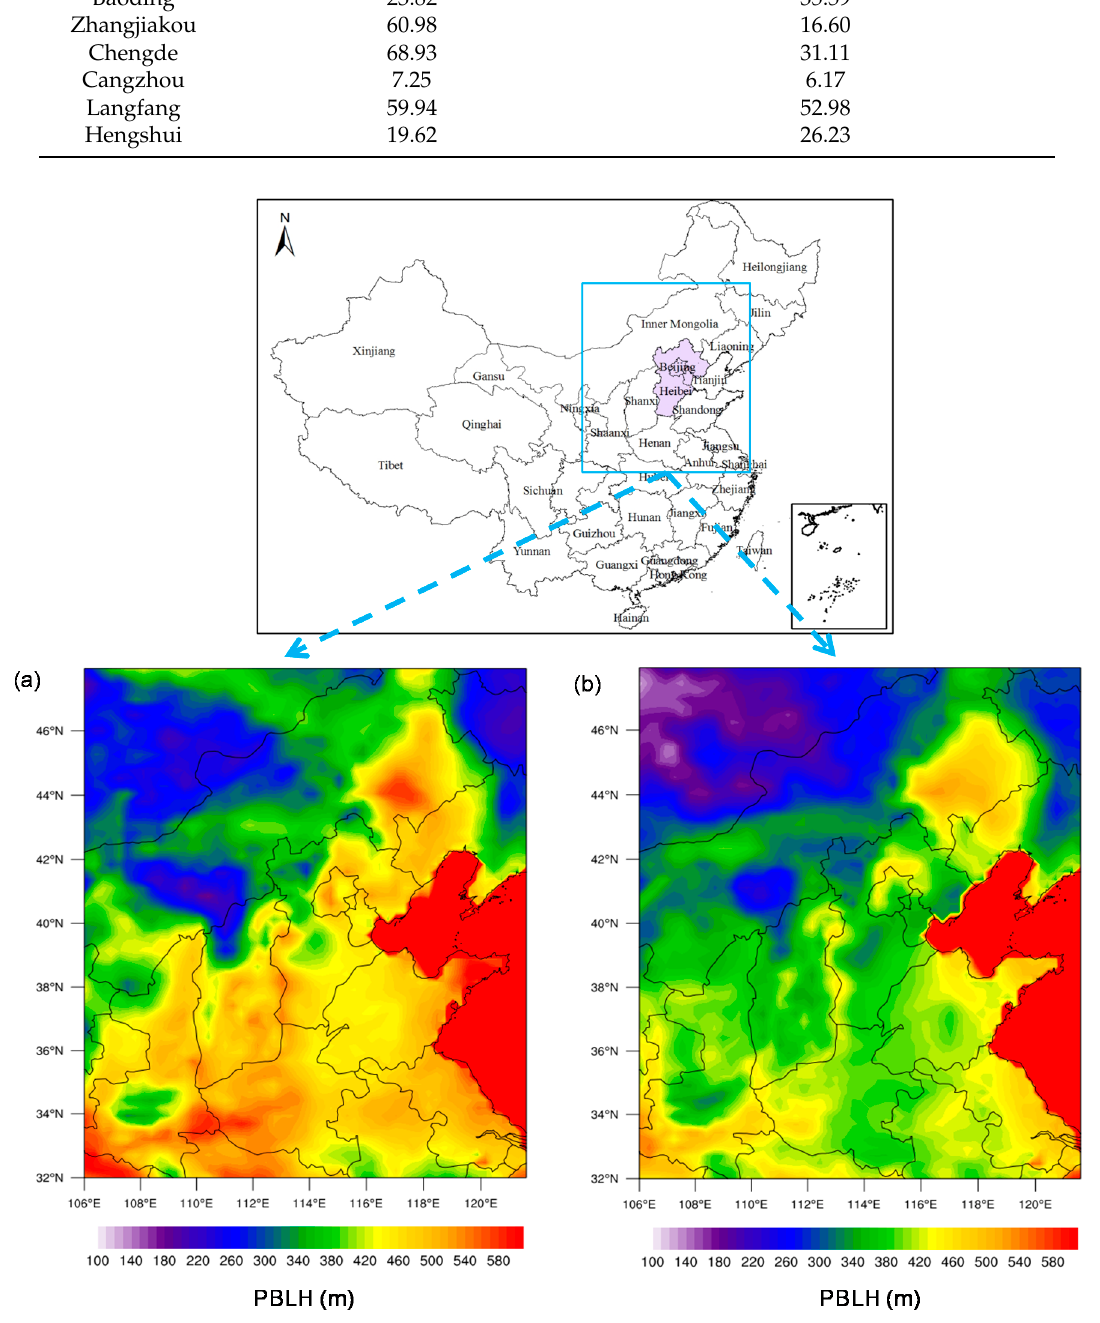
Figure 7. The monthly mean PBLH in JJJ region in ( a ) January 2016 and ( b ) January 2017. Table 8. Impacts of meteorological conditions on the PM 2.5 pollution in 13 cities in JJJ.